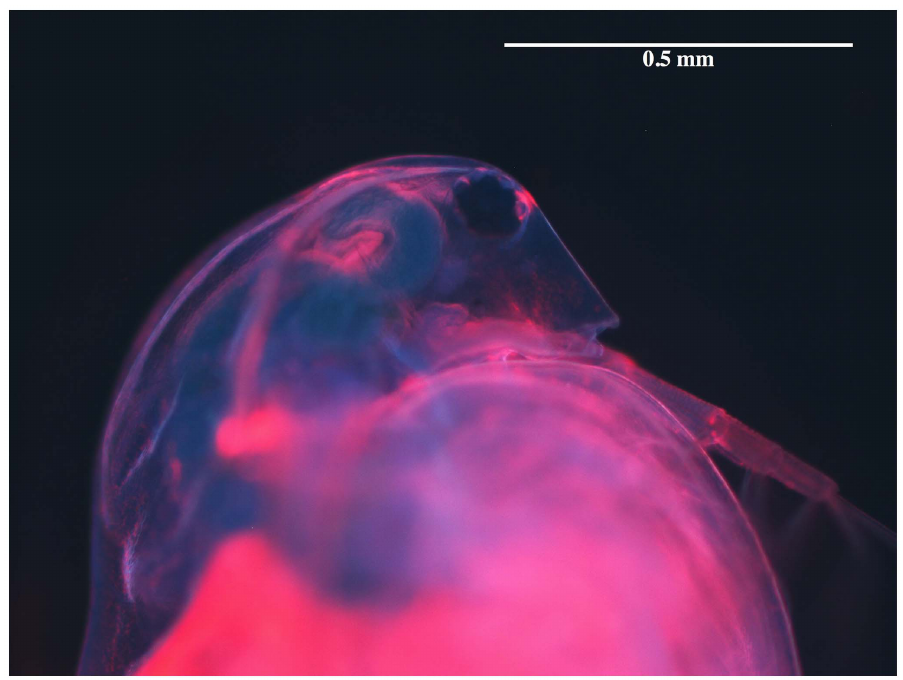
Figure 3. Fluorescence from a quantum-dot-labelled organism. Optical microscope image of a D. magna labelled with poly-L-lysine coated quantum dots that fluoresce at 655 nm (red). The blue light in the picture is scattered excitation light. (See also Video S1 for a video of labelled Daphnia magna swimming around.).